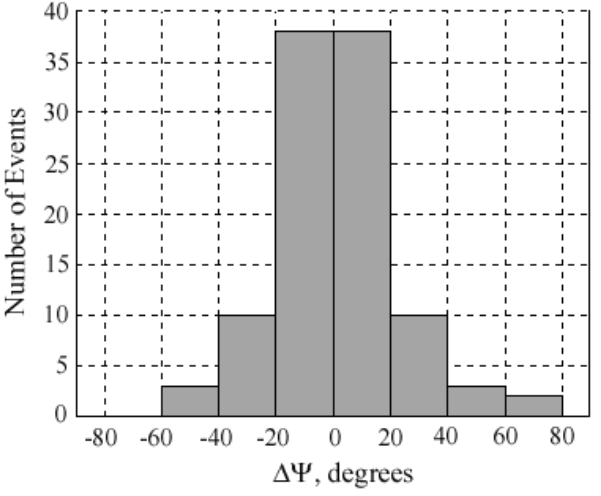
Fig. 5. Histogram distribution for the difference between the direc- tion of the plasma flow, according to SuperDARN measurements, and the orientation of cross-field anisotropy, according to scintilla- tion measurements at Barentsburg (Spitsbergen Archipelago). Data include scintillation receiver detection of single and double-peaks in the latitudinal profile of σ 2 χ . Total number of events is